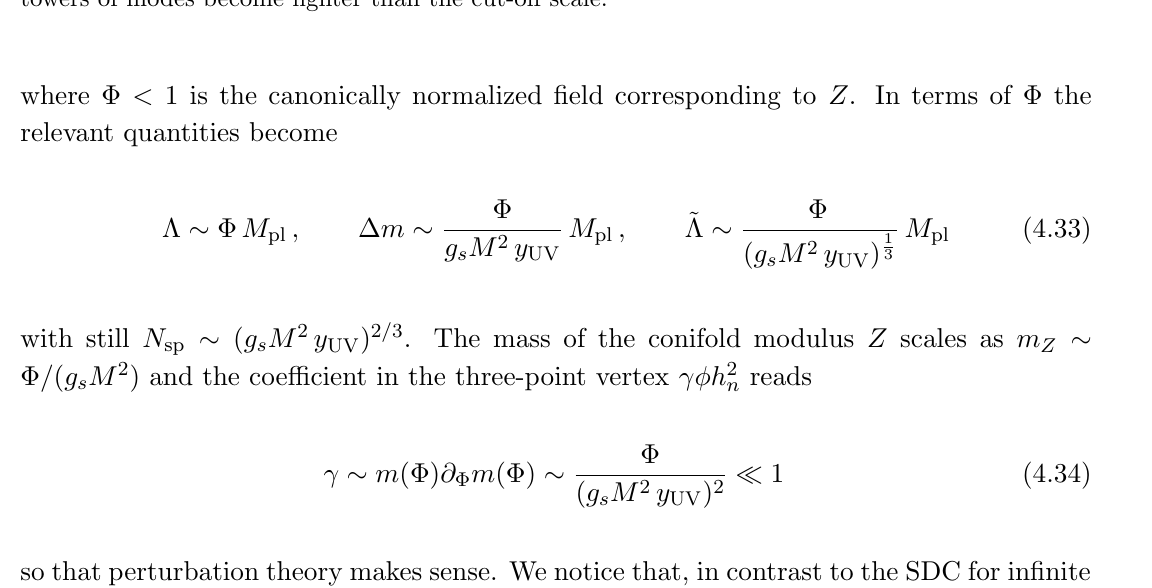
Figure 10 . A sketch of the complex structure \moduli space" of a warped Calabi-Yau. The red/blue regions are a neighborhood of the large complex structure and conifold points where towers of modes become lighter than the cut-o(cid:11)